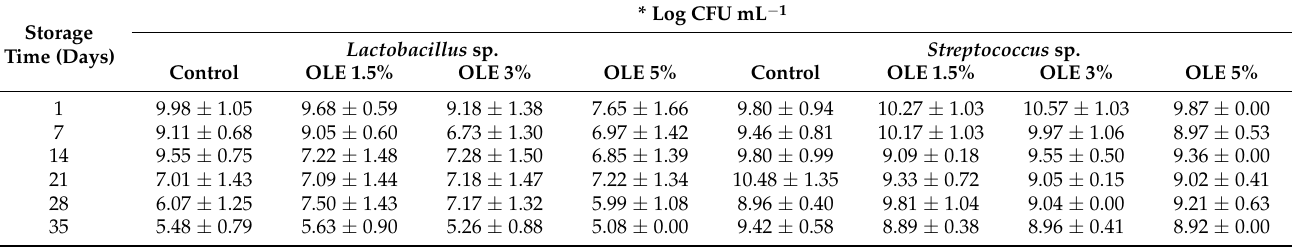
Table 4. Viable counts of Lactobacillus sp. and Streptococcus sp. in yoghurt samples without (control) and with the addition of olive leaf extract (OLE 1.5%, OLE 3%, and OLE 5%) during 35 days of cold storage.